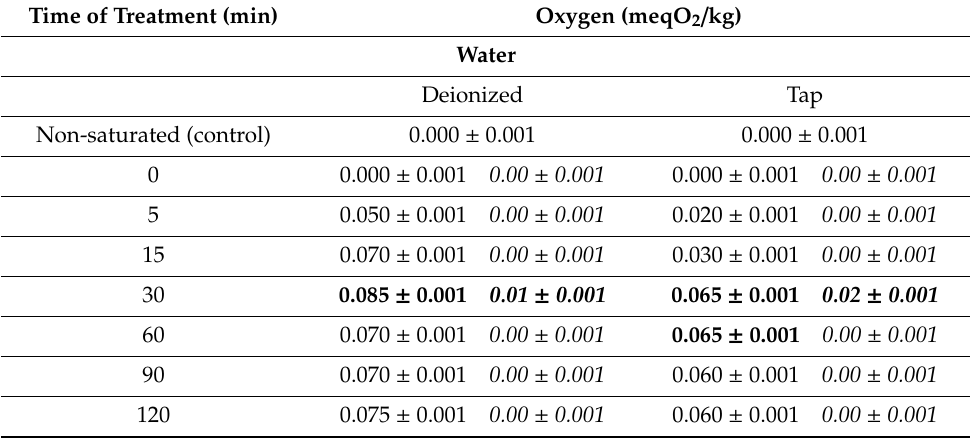
Table 5. Active oxygen content (meqO 2 / kg) in deionized and tap water a . Time of Treatment (min) Oxygen (meqO 2 / kg) Water Deionized Tap Non-saturated (control) 0.000 ± 0.001 0.000 ±